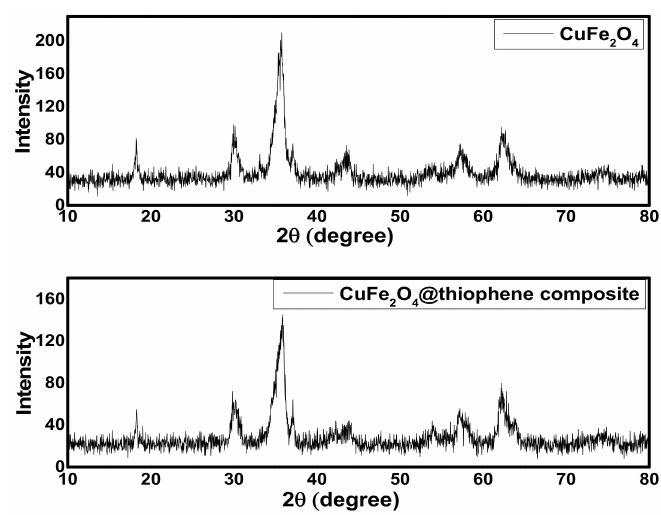
Figure 1. The x-ray diffraction (XRD) patterns of CuFe 2 O 4 nanoparticles and CuFe 2 O 4 @Polythiophene